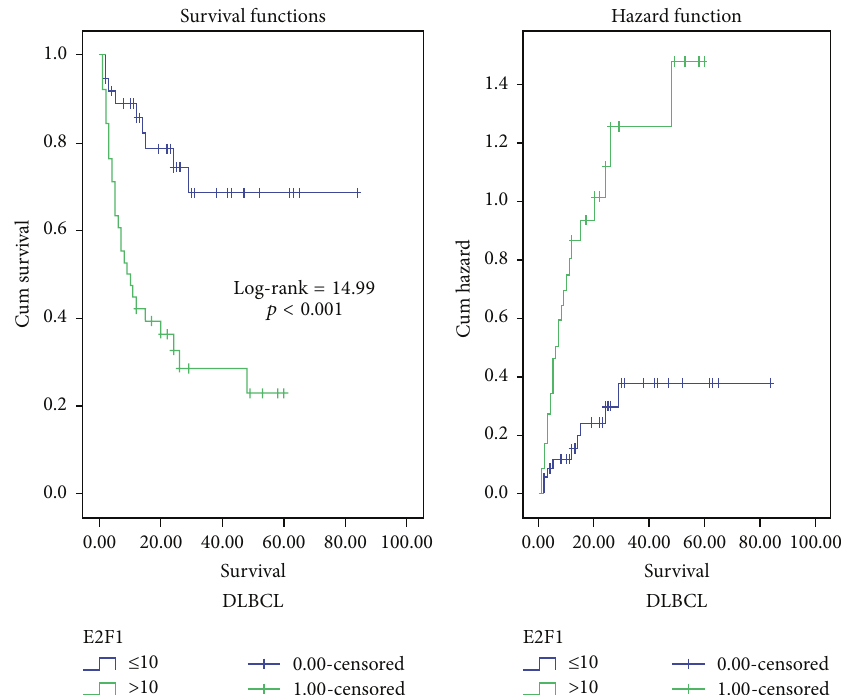
Figure 7: Kaplan-Meier and hazard function curve of OS for DLBCL patients with low and high E2F1 expression indicating that high E2F1 expression was more